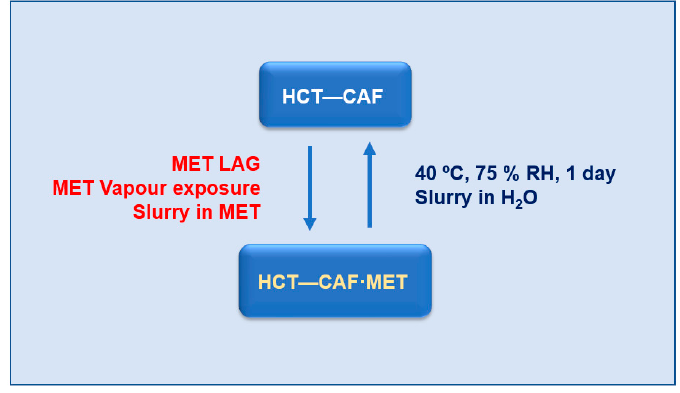
Figure S1: PXRD patterns of HCT–CAF obtained by grinding the two components at di ff erent molar ratios. Dotted lines indicate characteristic HCT reflections, Figure S2: Rietveld fit (red line) to the experimental PXRD data (blue line) of HCT–CAF (a) and HCT–CAF · MET (b). The Rietveld refinement for both the co-crystal and its solvate structure shows low discrepancy (grey line), Figure S3: ORTEP representation showing the asymmetric unit of HCT–CAF with atom numbering scheme (thermal ellipsoids are plotted with the 50% probability level), Figure S4: ORTEP representation showing the asymmetric unit of HCT–CAF · MET with atom numbering scheme (thermal ellipsoids are plotted with the 50% probability level), Figure S5: Combined QTAIM / NCIplot analysis of the H-bonded HCT ··· HCT homodimer (a) and CAF ··· HCT heterodimer (b) extracted from the solid-state X-ray structure of compound HCT–CAF · MET, Figure S6: Combined QTAIM / NCIplot analysis of the π -stacked CAF ··· CAF homodimer (a) and CAF ··· HCT heterodimers (b,c) extracted from the solid-state X-ray structure of compound HCT–CAF · MET, Figure S7: PXRD patterns of HCT–CAF and HCT–CAF · MET after the stability slurry assay (at 25 ºC, during 24 h, in water). Di ff ractograms are nearly identical, highlighting HCT–CAF as the most thermodynamically stable species, Figure S8: PXRD pattern of HCT–CAF and its conversion to HCT–CAF · MET